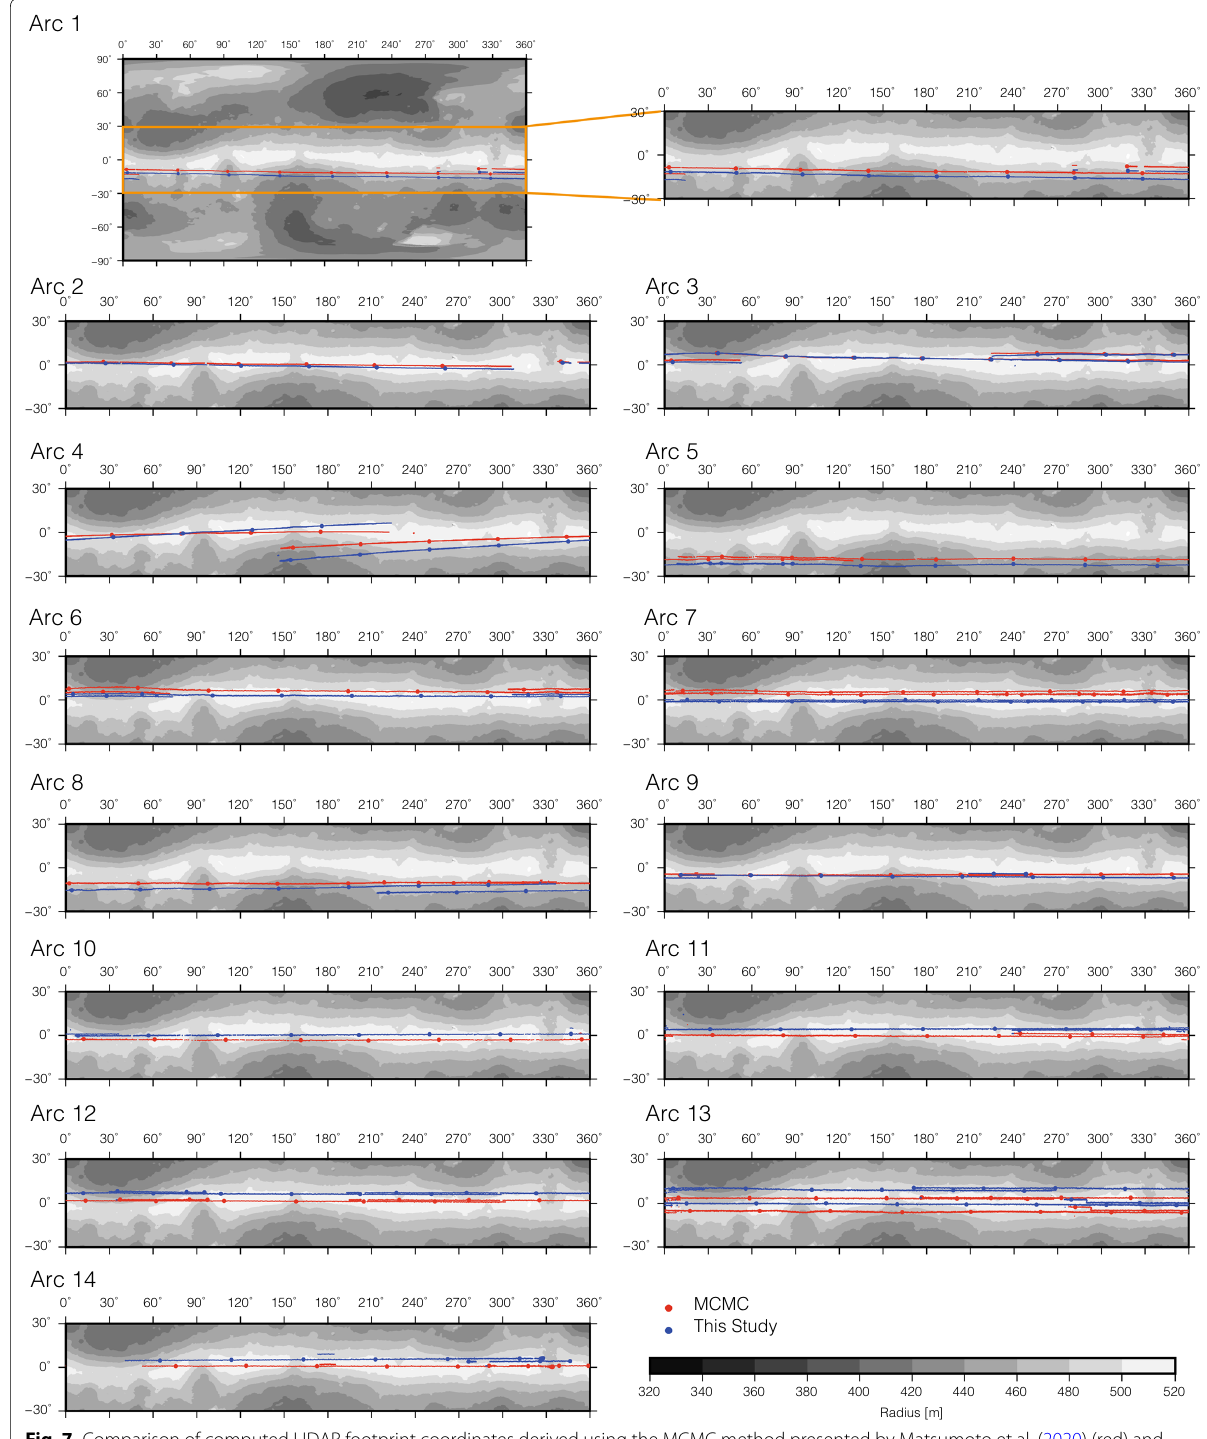
Fig. 7 Comparison of computed LIDAR footprint coordinates derived using the MCMC method presented by Matsumoto et al. (2020) (red) and this study (blue). The hourly footprint position is indicated by a dot representing the longitudinal position differences. The background shows the topographic height of the Ryugu shape model measured from the center of